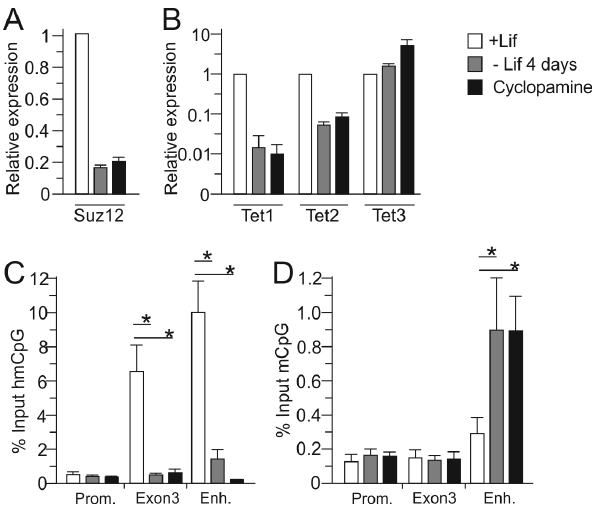
Figure 4. Expression of Suz12 and Tet genes correlated with the presence of methylcytosine (5mC) and hydroxymethylcytosine (5hmC) at the Avp locus during hypothalamic-like differentia- tion. A, Suz12 gene expression rapidly decreased following 4 days of Lif withdrawal. B, Similarly, Tet1 and Tet2 , but not Tet3 , gene expression rapidly declined following 4 days of Lif withdrawal. C, MeDIP showed high hydroxymethylation (5hmC) at the Avp gene body and down- stream enhancer which strongly decreased upon Lif-withdrawal. Application of cyclopamine evoked a further decline at the enhancer region. D, Conversely, methylation (5mC) at the Avp enhancer, but not at the gene body, increased as evidenced by MeDIP. Bars represent standard deviations from the mean (sem), *, P , 0.05; from3 indepen- dent experiments performed in duplicate.